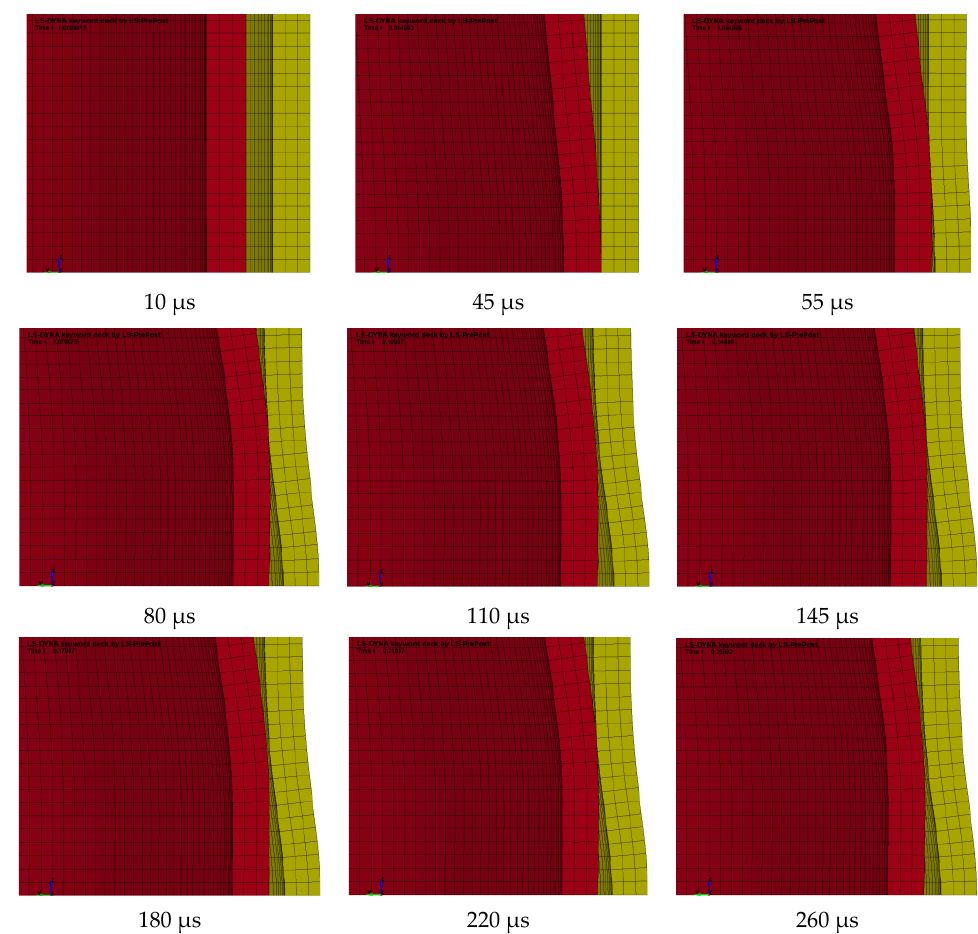
Figure 14. Collision process of double-layer steel cylindrical shells.